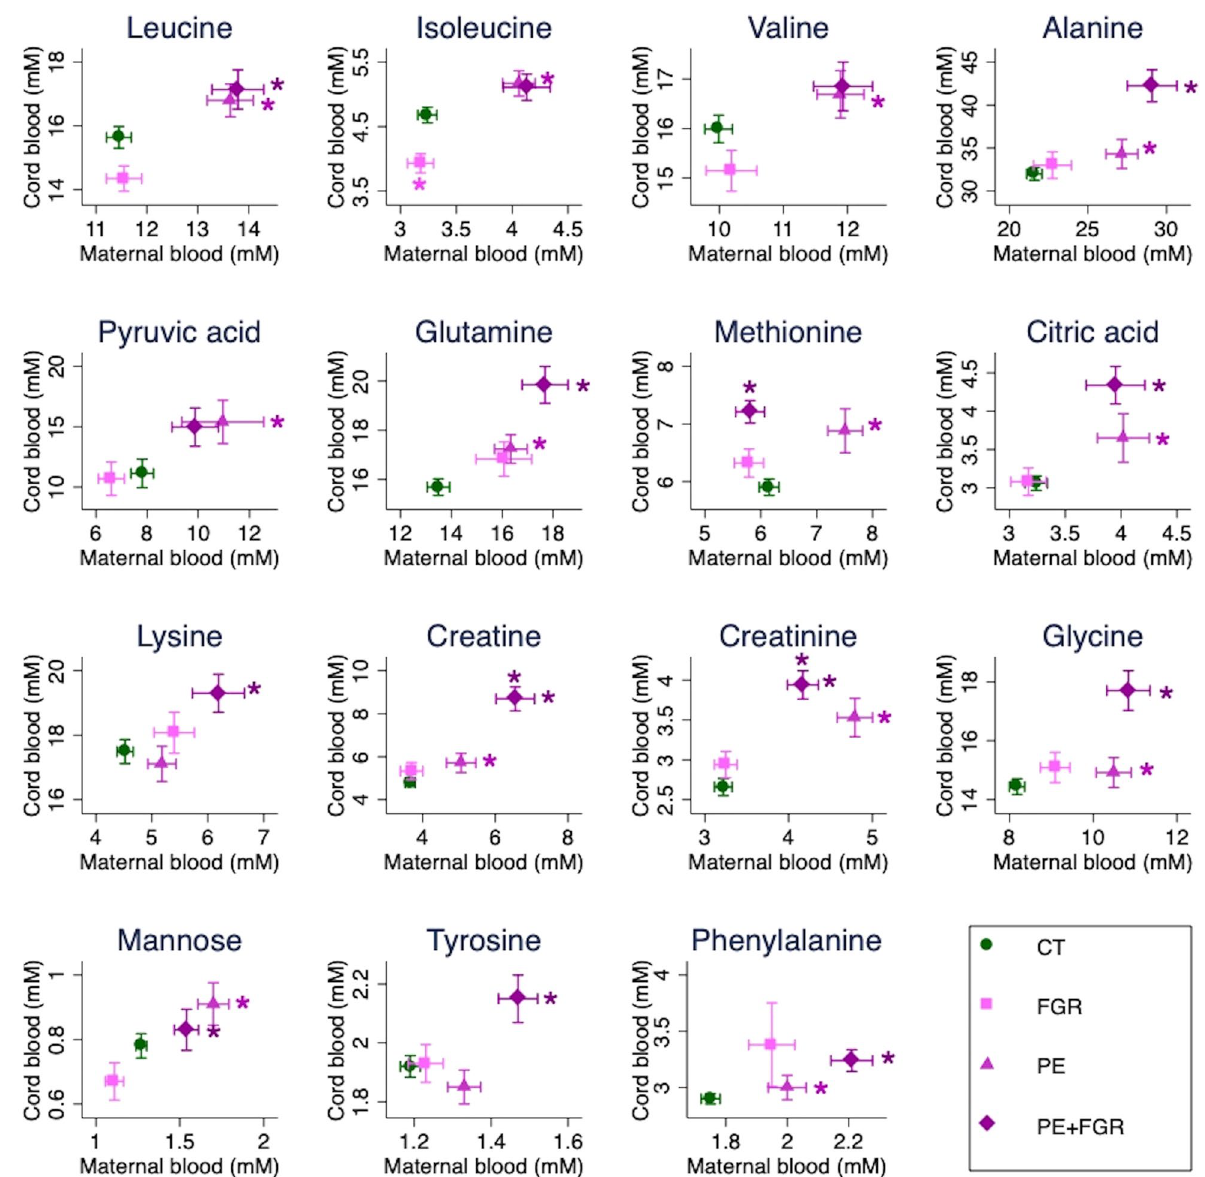
Figure 4. Low-molecular-weight metabolite profiles across the different groups. Plasma samples from maternal (X-axis: controls [n = 88], FGR [n = 44], PE [n = 40], PE + FGR [n = 50]) and cord blood (Y-axis: controls [n = 86], FGR [n = 43], PE [n = 37], PE + FGR [n = 50]) plasma samples. The plots show the mean values in each group + /− SEM. * p < 0.05 according to Student’s t -test or Mann Whitney U test and confirmed by linear regression (adjusted for maternal body mass index, smoking, sample collection date, gestational age at delivery/ sampling, route of delivery and fetal gender) and 5% false discovery rate correction compared to controls (Supplementary Table S1). CT, controls; FGR, fetal growth restriction; PE,